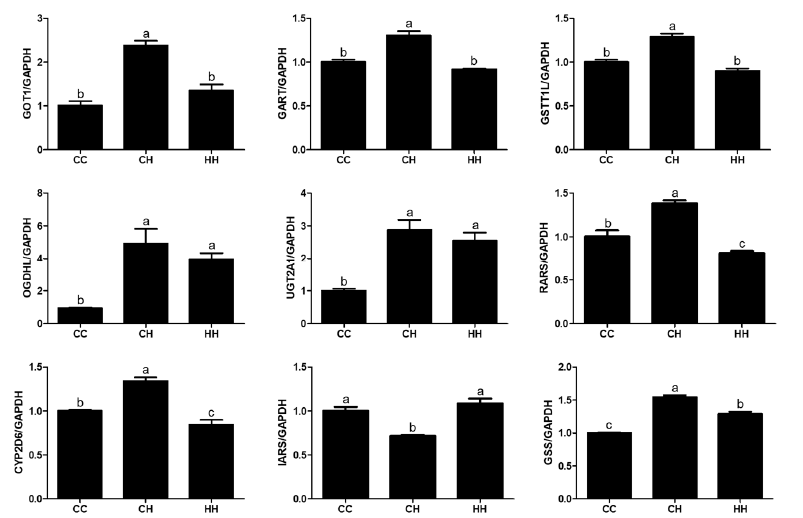
Figure 4. Gene expression in the liver tissue. The values were expressed with fold-change compared to CC. CC: raised at a suitable temperature without heat exposure; CH, chronic heat exposed group; HH, early and chronic heat exposed group. a–c Different superscript letters are significantly different ( p < 0.05).